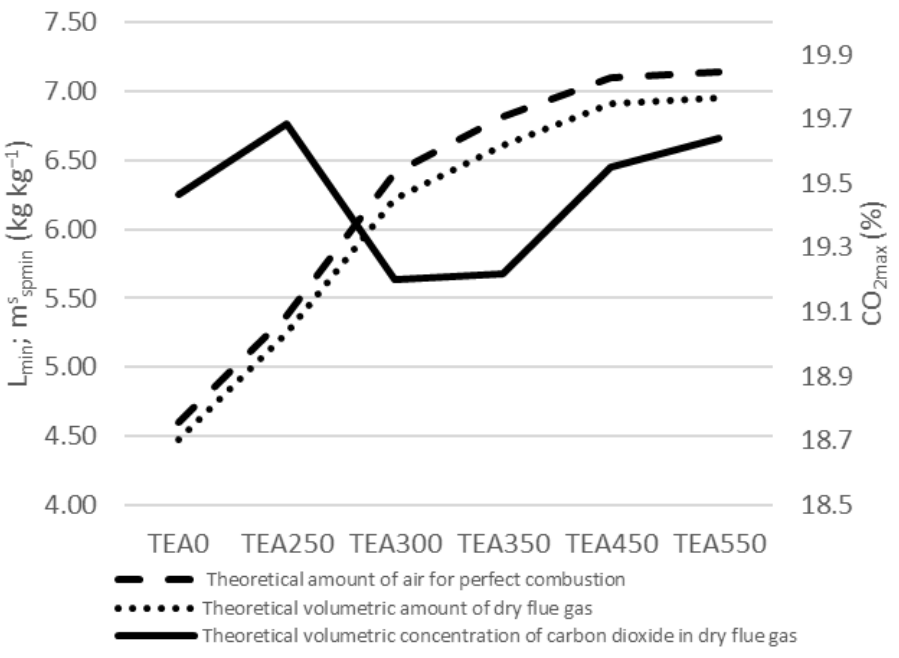
Figure 9. Volumetric combustion of tea waste.